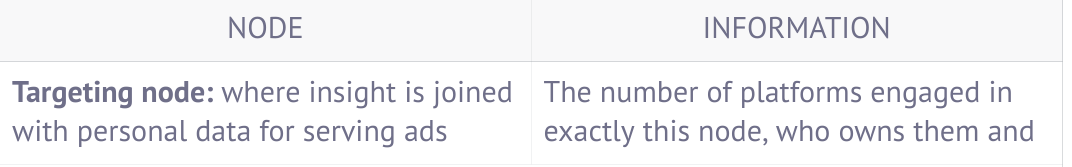
TABLE 1: Three nodes of power stemming from the function of data and the related information